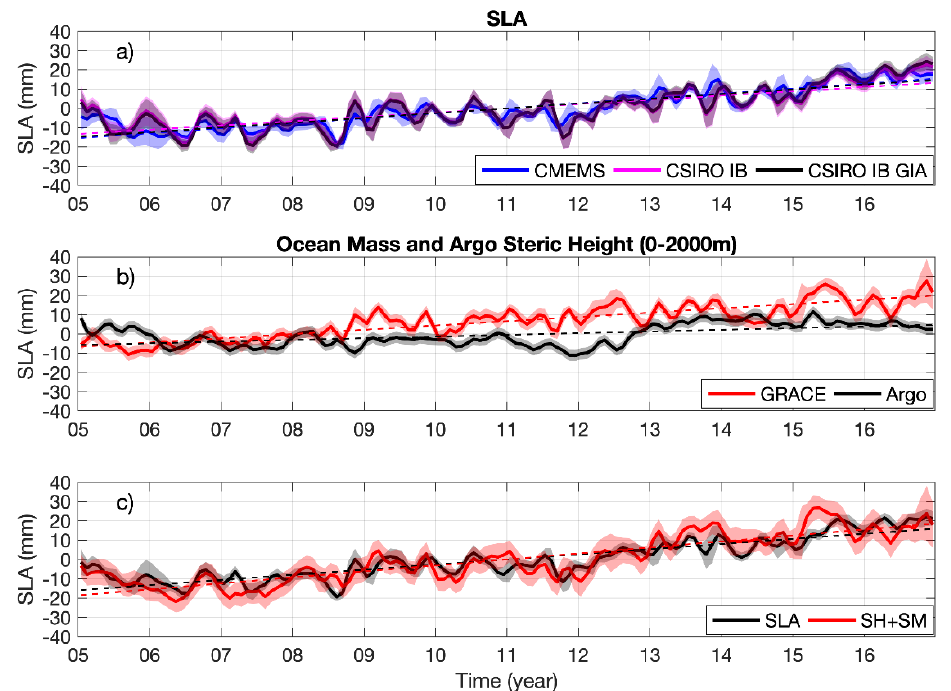
Figure 6. South Atlantic mean sea level (SAMSL) time series without seasonal cycle derived from ( a ) CMEMS, CSIRO and CSIRO corrected by GIA, ( b ) GRACE and Argo (steric height) and ( c ) average of CMEMS and CSIRO corrected by GIA (SLA) and the sum of GRACE (SM) and Argo (SH) for the period January 2005 to December 2016. The dashed lines represent the linear regression. The blue, red and black shaded areas represent one standard error. Units: mm.